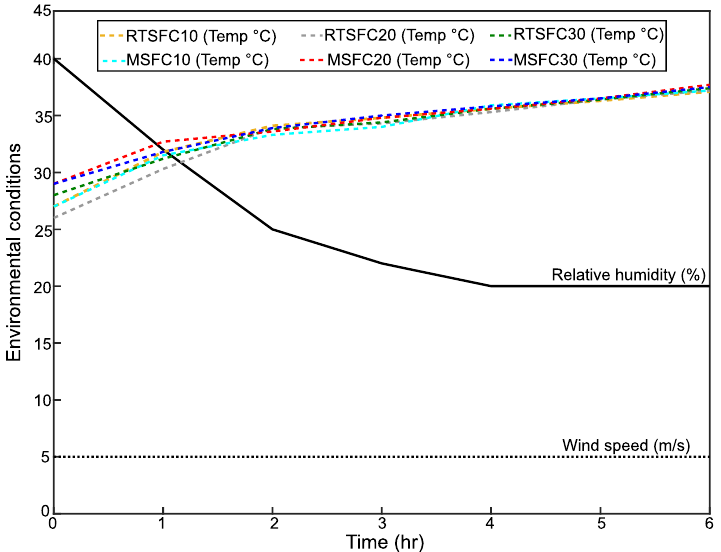
Figure 15. Environmental conditions for all